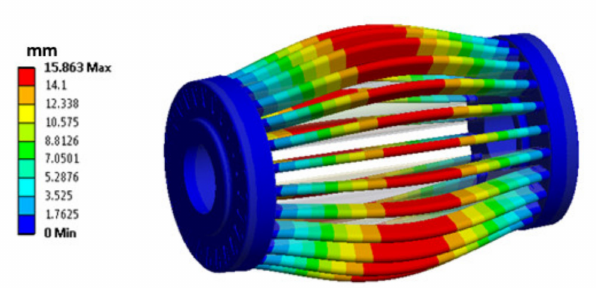
Figure 12. Rotor squirrel-cage deformation at 50 krpm, without support of laminations.